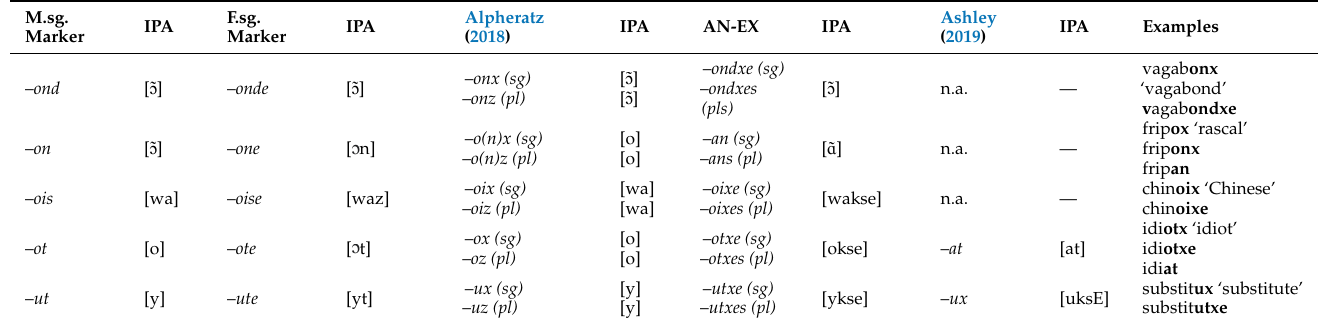
Table 2. Masculine and Feminine Homophones.